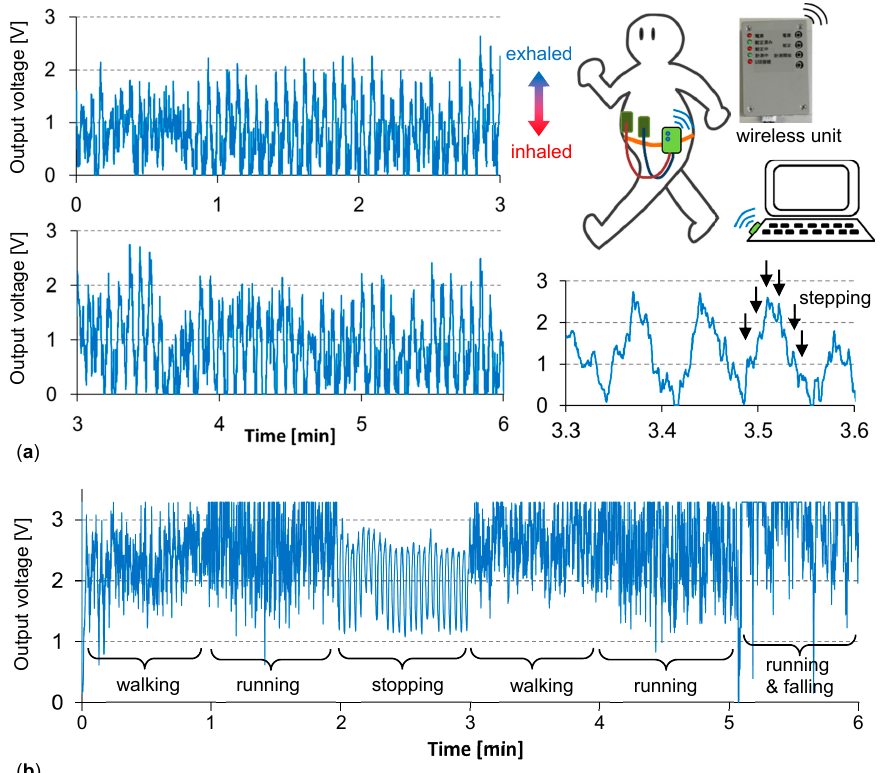
Figure 5. Abdomen capacitance signals measured by the wireless unit ( a ) during gentle walking and ( b ) during harder walking for 6 min.